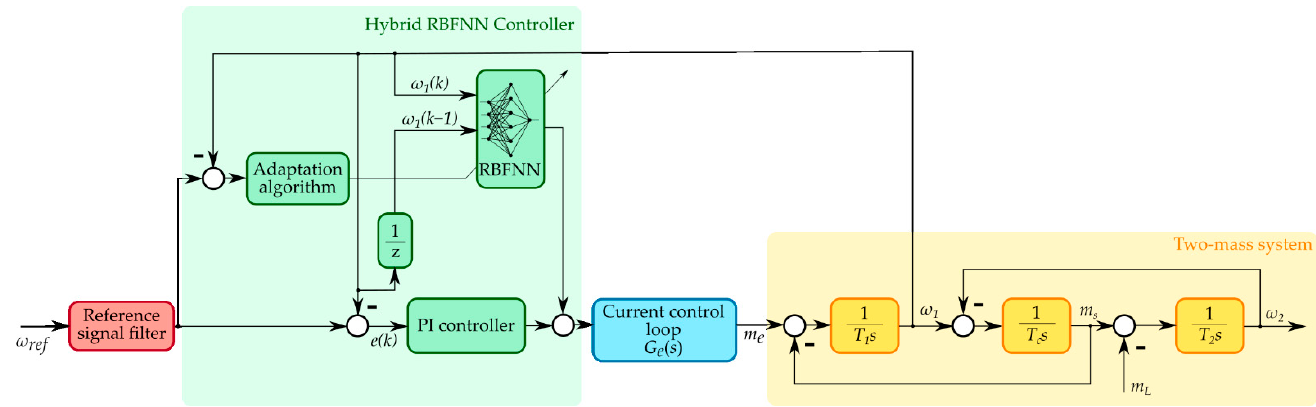
Figure 1. The block diagram of the proposed control structure with the hybrid controller.